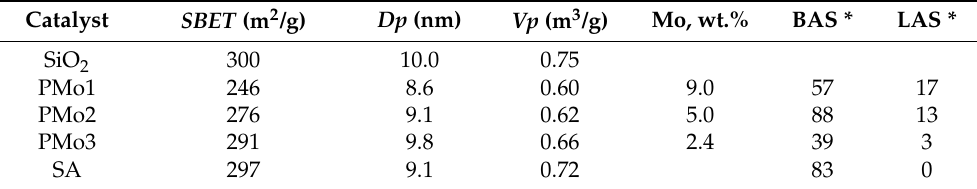
Table 3. Elemental analysis results, textural characteristics, and catalyst acidity. Catalyst SBET (m 2